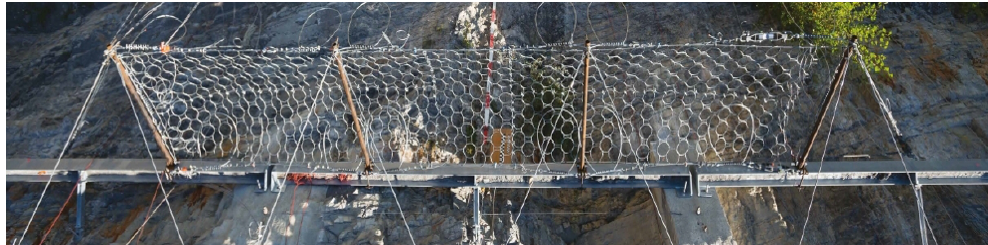
Figure 1. Top view of the experimental set-up (by courtesy of the NGE